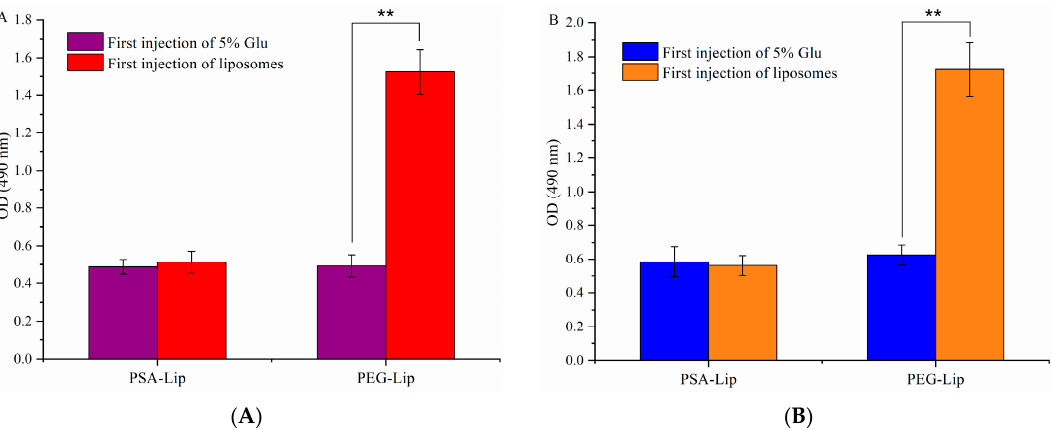
Figure 6. Anti-PEG (PSA) IgM production induced by the initial injection ( A ) in wistar rats and ( B ) in beagle dogs. Data were shown as mean ± S.D., n = 3. ** p < 0.01.